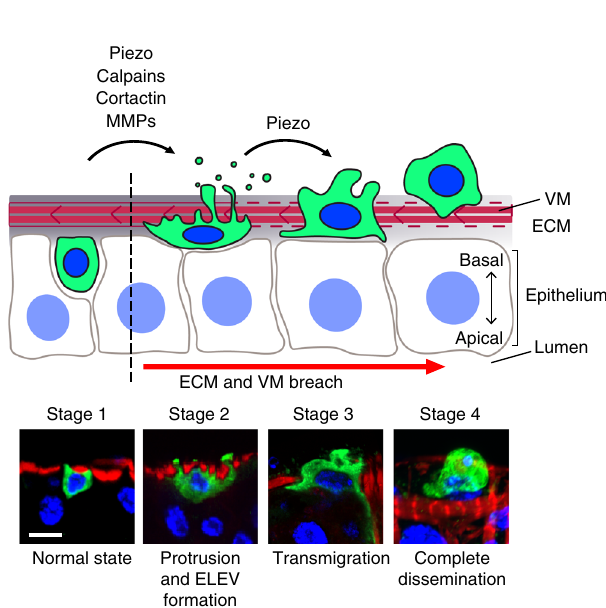
Fig. 7 Schematic stages of cell dissemination. Stages of cell dissemination were reconstituted based on confocal images of fi xed Ras V12 cells and ex vivo live imaging of esg ts > Ras V12 posterior midguts. Lower panels show representative confocal images of control ( esg ts ; stage 1) and Ras V12 cells (stages 2 – 4). An esg ts cell is illustrated in stage 1. In the absence of Ras V12 expression, ISCs and EBs reside within the midgut epithelia. Upon Ras V12 expression, invasive protrusions are formed at the basal side of the cells, and Mmp1 levels increase. Stage 2 illustrates a Ras V12 cell producing large protrusions/blebs and ELEVs across the VM. These cells could be observed at days 2 and 3 of Ras V12 expression. Stages 3 and 4 illustrate Ras V12 cells under and after transmigration, respectively. Disseminated cells were frequently detected at days 2 and 3 of Ras V12 expression. Scale bar, 10 µ